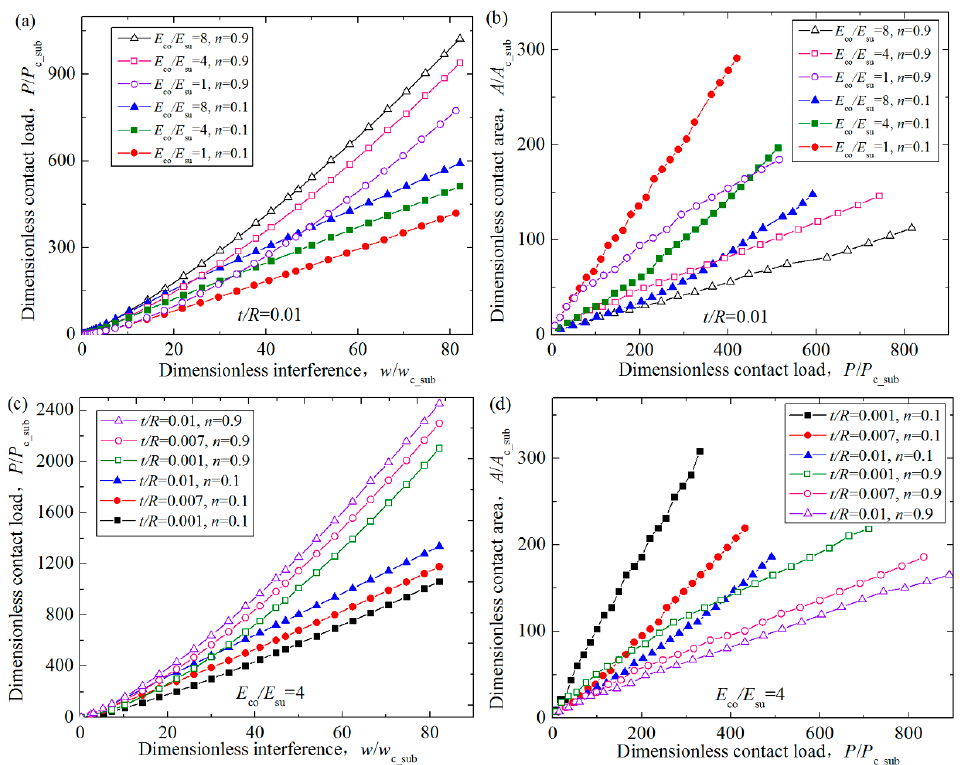
Figure 6. The effect of the Young’s modulus ratios and dimensionless coating thicknesses on the dimensionless contact load P/P c_sub and area A/A c_sub at different hardening exponents of the substrate n = 0.1, 0.9, where ( a ) P/P c_sub vs. w / w c_sub and ( b ) A/A c_sub vs. w / w c_sub are for the cases where the Young’s modulus ratios E co /E su = 1, 4, 8 and the dimensionless coating thickness t/R = 0.01; ( c ) P/P c_sub vs. w / w c_sub and ( d ) A/A c_sub vs. w / w c_sub are for the cases where the dimensionless coating thickness t/R = 0.001, 0.007, 0.01 and the Young’s modulus ratios E co /E su = 4.